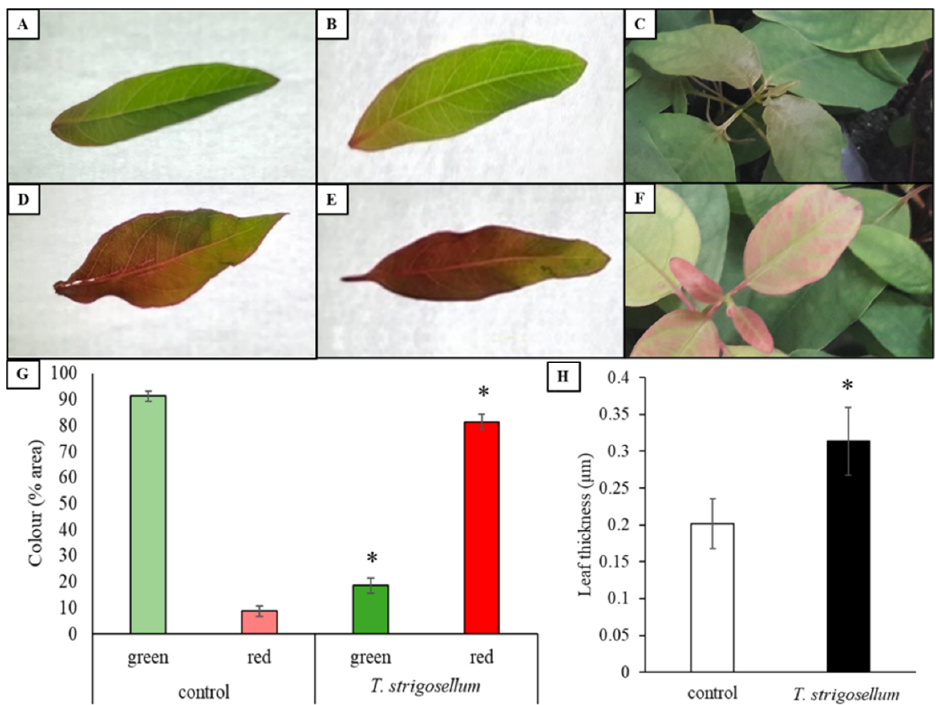
Figure 6. Changes in leaf color of Eucalyptus urophylla inoculated with Trichoderma strigosellum . Control ( A – C ) and T. strigosellum treatment ( D – F ). ( G ) Quantification of the relative leaf area spectrally identified as green and red in leaves of E. urophylla . Asterisks (*) in T. strigosellum treatment indicate values determined by the Tukey test to be significantly different ( p < 0.05) from the control. Each column corresponds to the mean of eight leaves ± standard error (SE); ( H ) leaf thickness (μm) of E. urophylla inoculated with T. strigosellum . Asterisks (*) in T. strigosellum treatment indicate values determined by the Tukey test to be significantly different ( p < 0.05) from the control. Each column corresponds to the mean of five plants ± standard error (SE).